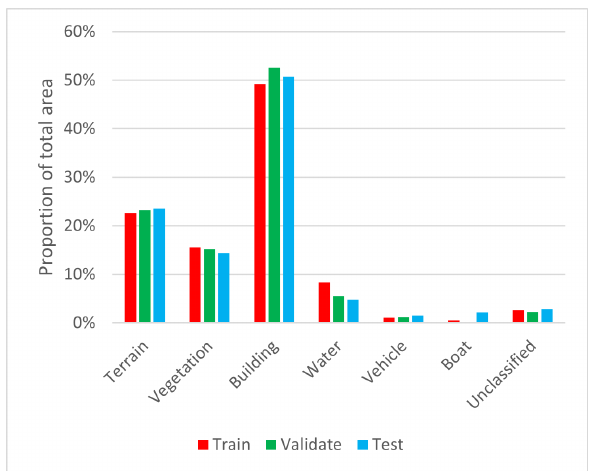
Figure 5. Surface distribution between classes for each